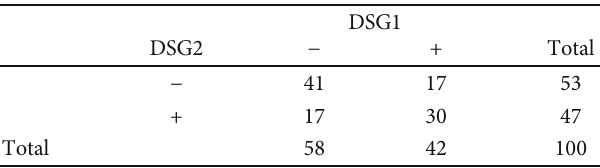
( P = 0 : 000 ) (Table 4, Figure 3). Furthermore, we de fi ned four groups by the expression of DSG1 and DSG2: positive expression of both DSG1 and DSG2 (+/+), positive DSG1 and negative DSG2 (+/ − ), negative DSG1 and positive DSG2 ( − /+), and both negative ( − / − ). Kaplan-Meier survival